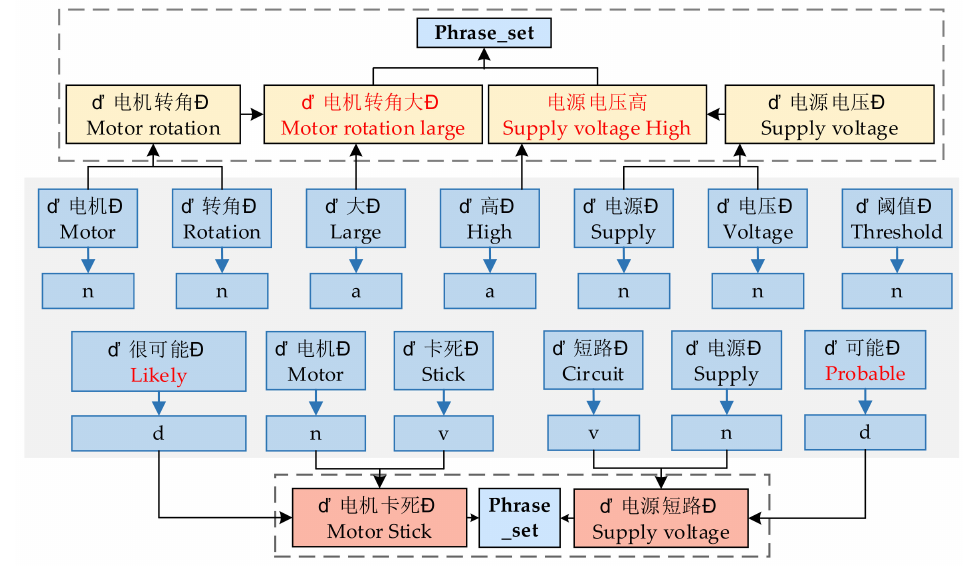
Figure 6. The set of phenomenon and cause phrases. Table 2. rule_set ({ p : x }, { f : y }). p f x 1 (Larger motor Angle and higher (It is possible that the motor is stuck or the power supply is